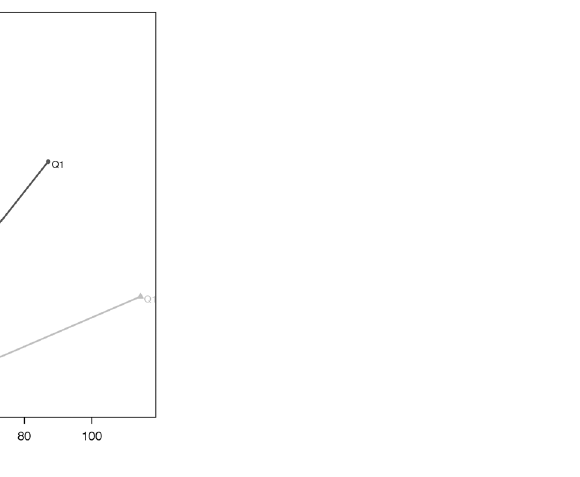
Fig 3. Expected health benefits (deaths averted) versus financial risk protection afforded (2011 US$), per $1,000,000 spent for universal public finance of pneumococcal vaccination and/or pneumonia treatment scale-up in Ethiopia, where results are shown for 5 income quintiles (I is poorest and V is